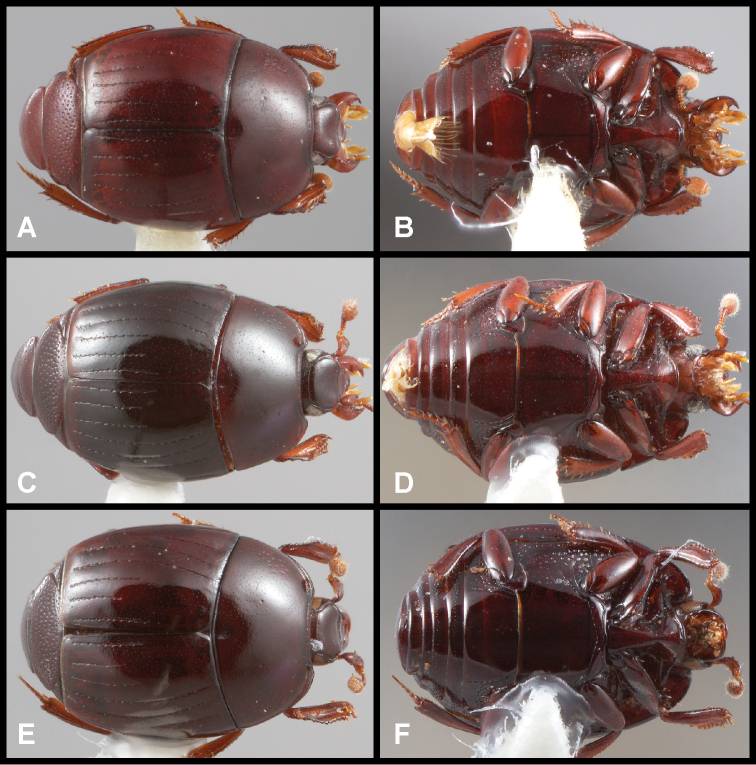
A, BPhelister
umens: A dorsal habitus B ventral habitus C, DP.
almeidae: C dorsal habitus D ventral habitus E, FP.
chicomendesi: E dorsal habitus F ventral habitus.